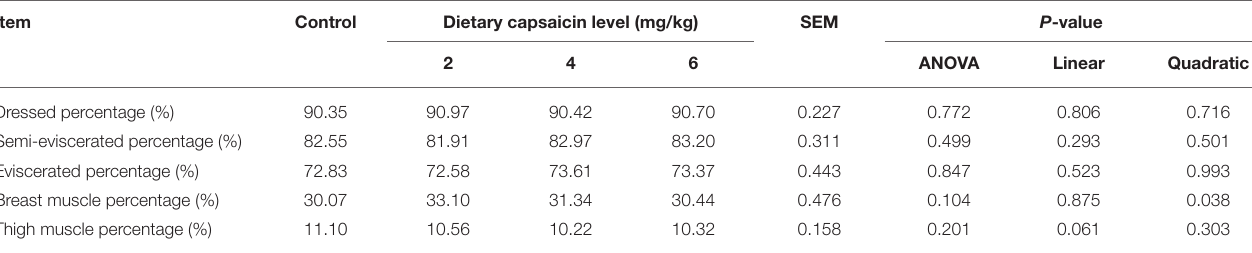
TABLE 3 | Effects of different levels of capsaicin on carcass traits of broilers at 42 d.